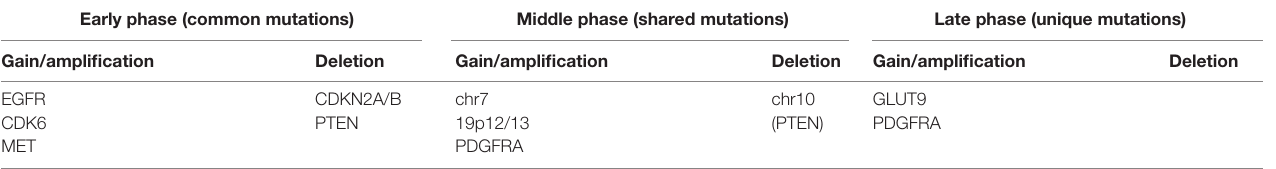
TABLe 2 | A summary of copy number variations during tumor